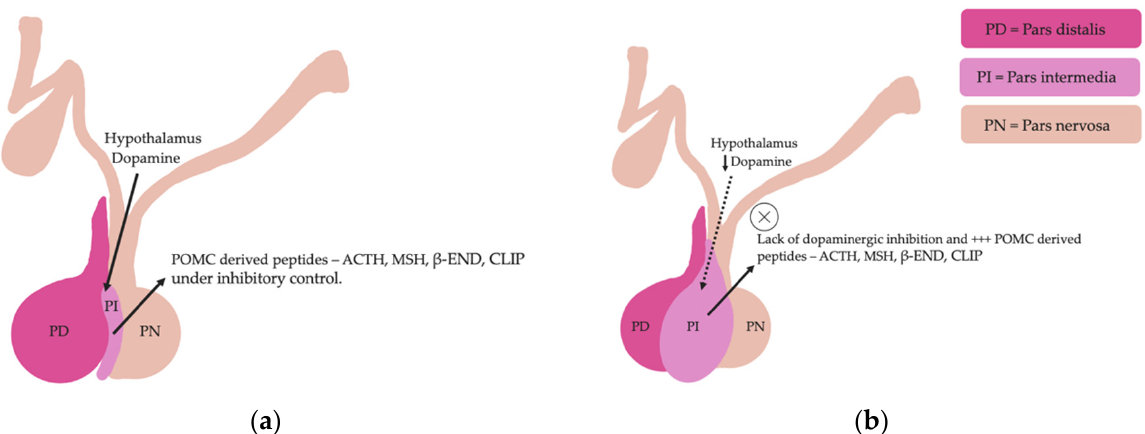
Figure 2. Normal equine pituitary gland ( a ). Equine pituitary gland affected by PPID demonstrating a loss of dopaminergic inhibition, and subsequent macroadenoma formation of the pituitary pars intermedia and overproduction of POMC derived peptides ( b ).